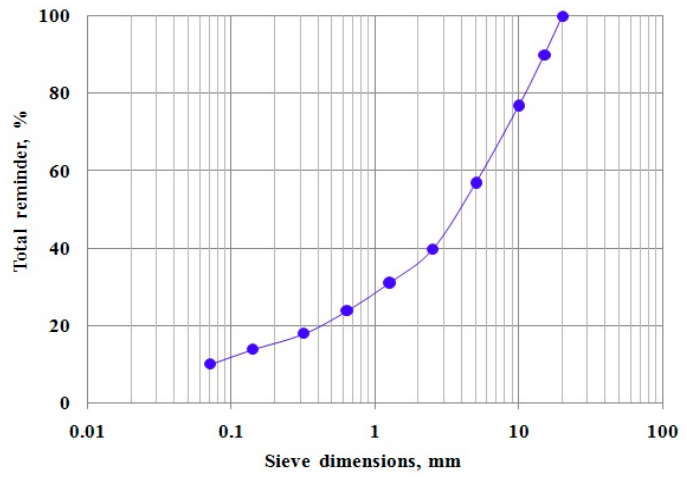
Figure 1. Granulometric curve of mineral part of the asphalt concrete.